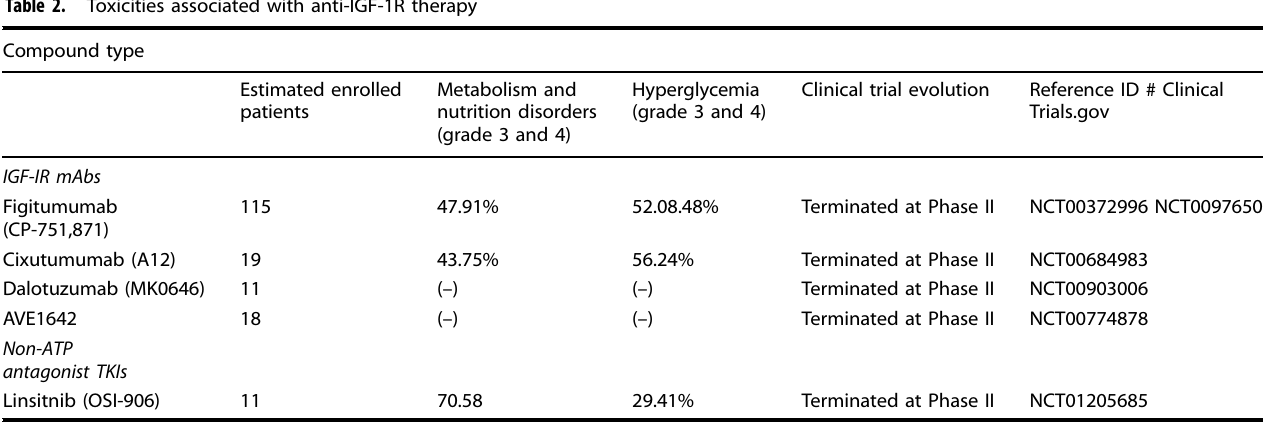
Table 2. Toxicities associated with anti-IGF-1R therapy Compound type